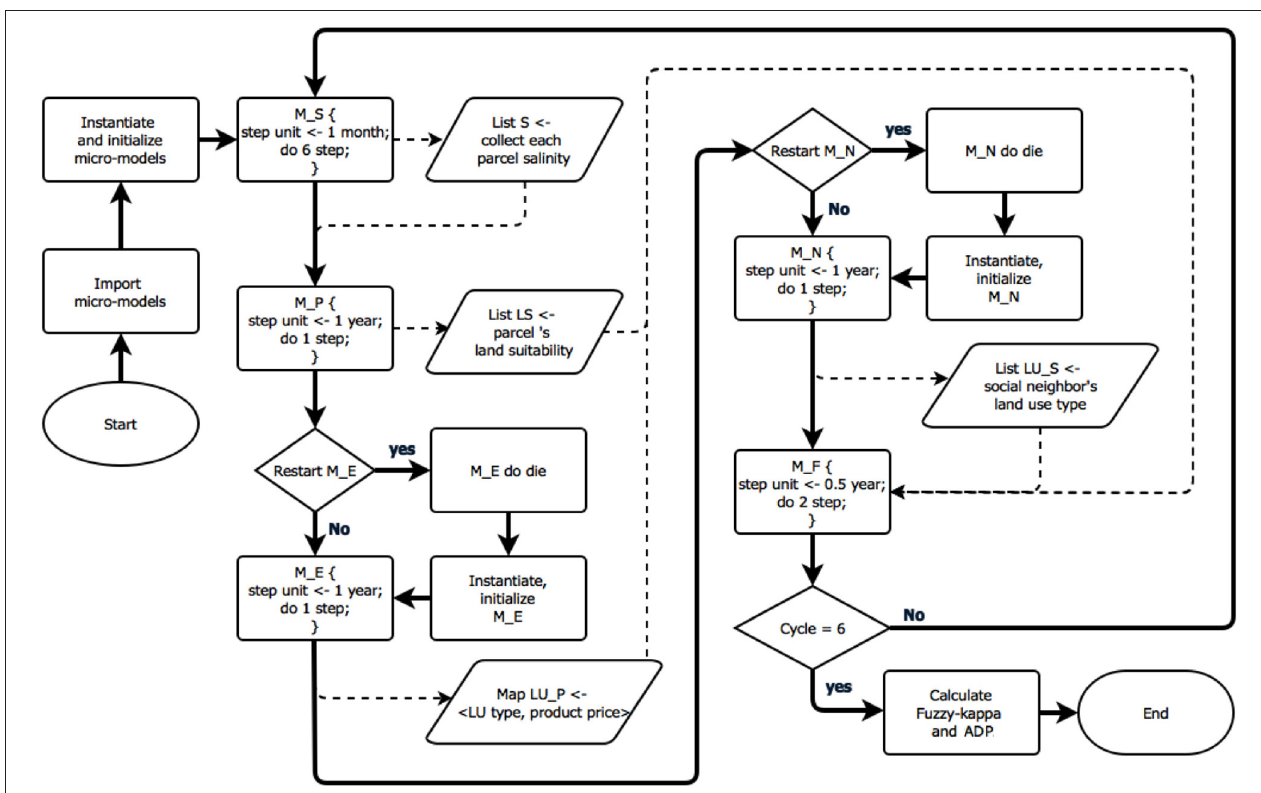
FIGURE 12 | Co-model workflow implemented in GAMA. Bold arrows are the flow of processes. Dotted lines represent the flows of data.